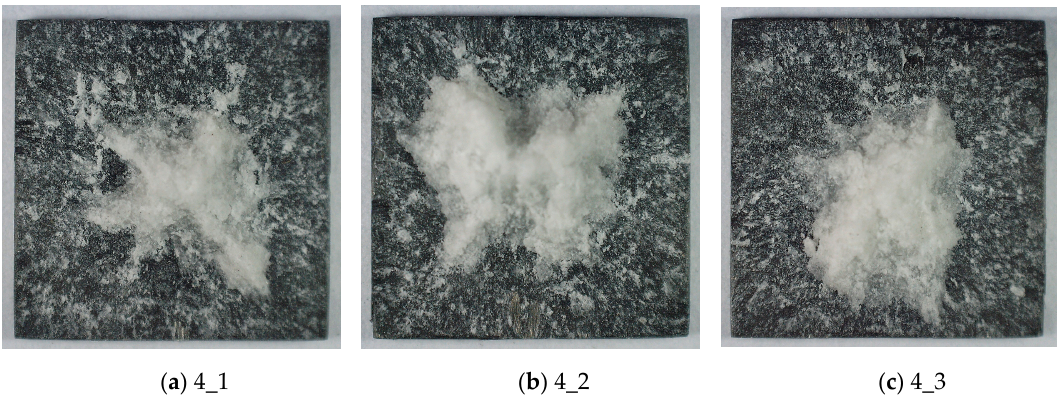
Figure 8. The TBC ceramic mat of samples after impact with the pressure of 1.5 bar. ( a ) sample 3_1 ( b ) sample 3_2 ( c ) sample 3_3.